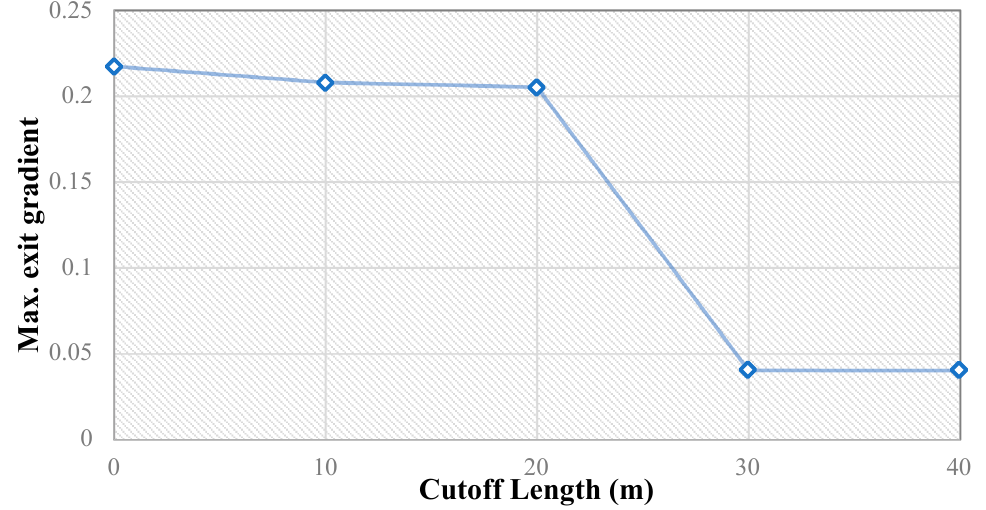
Figure 12. Maximum outlet gradient of downstream in different cutoff lengths.